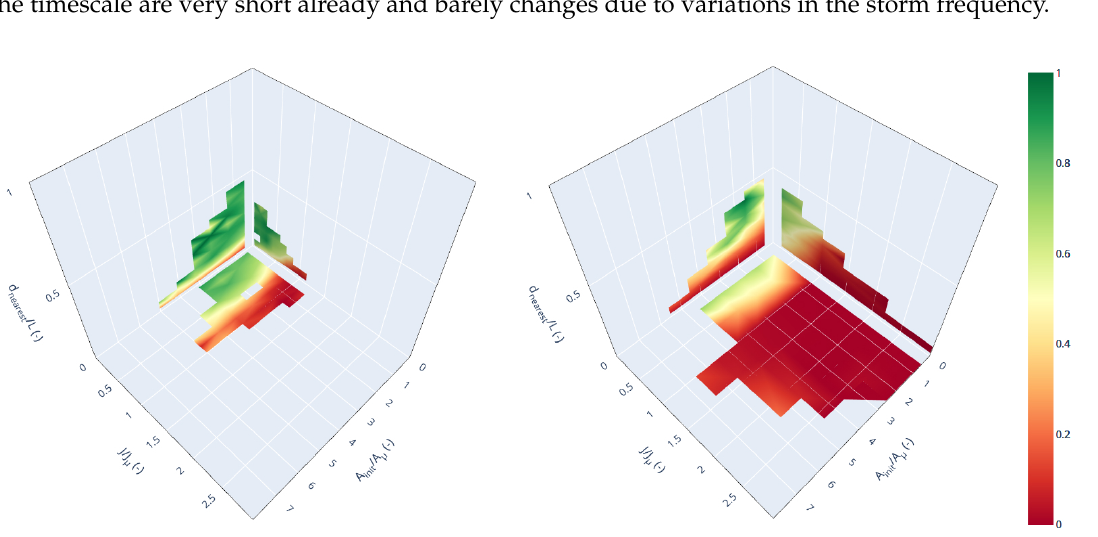
Figure 6. Breach survival chance shown for the simulations of Great South Bay (left) and Core Sound (right) sets of parameter values (see Table 1), in three histograms for varying values of relative initial breach size A init / A µ , barrier coast saturation J / J µ , and distance to nearest neighboring inlet d nearest .